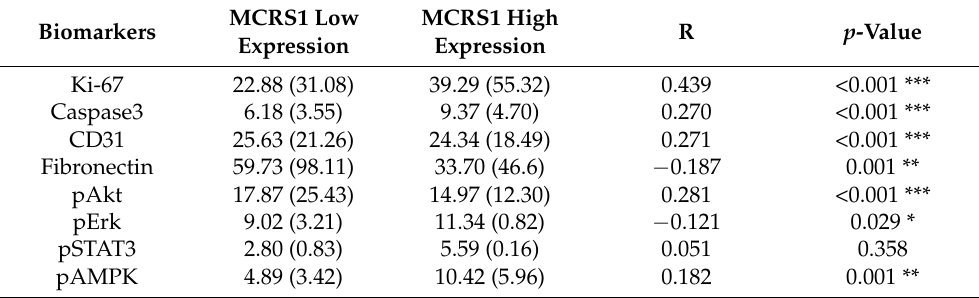
Table 3. Correlation of MCRS1 with common tumor proliferation and invasion markers and the expression level of MCRS1 in the H-Score of different biomarkers. (* p -Value < 0.05; ** p -Value < 0.01; *** p -Value <